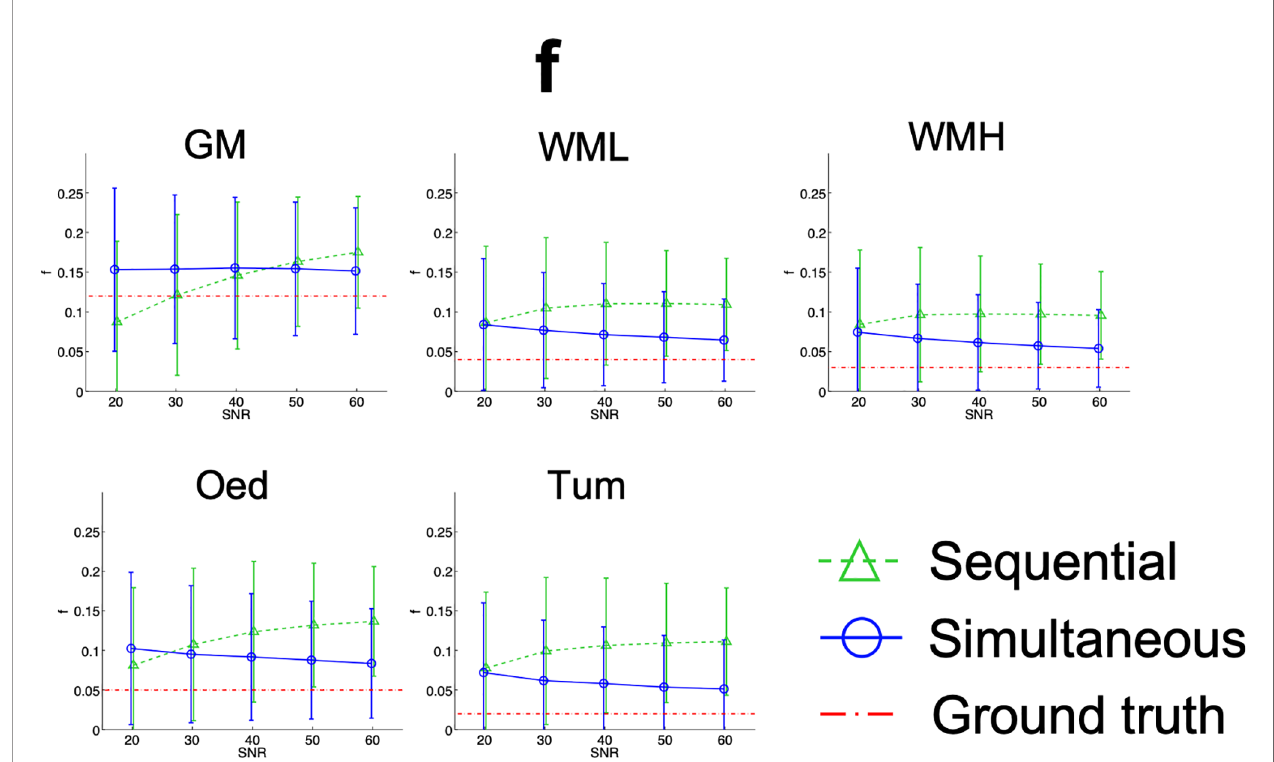
FIGURE 7 | Simulation results plots of f in all tissues at all SNR levels. The geometric fi gures represent the mean and the vertical bars the standard deviation at each SNR